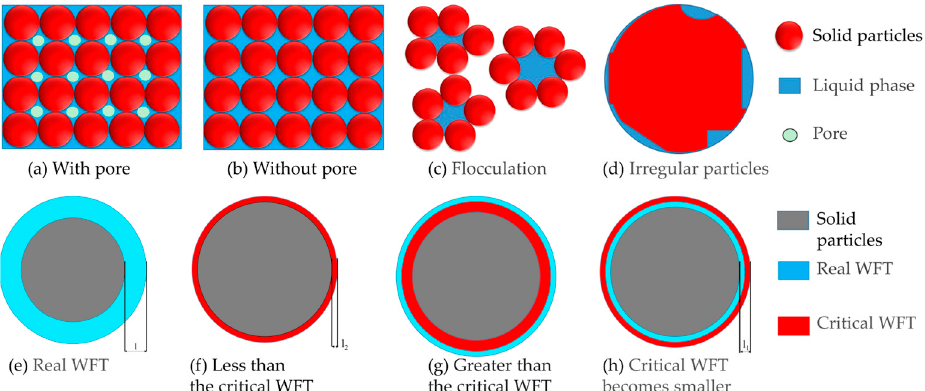
Figure 1. The schematic diagram of the filling state of the liquid phase between particles ( a – d ) and water film ( e – h ).